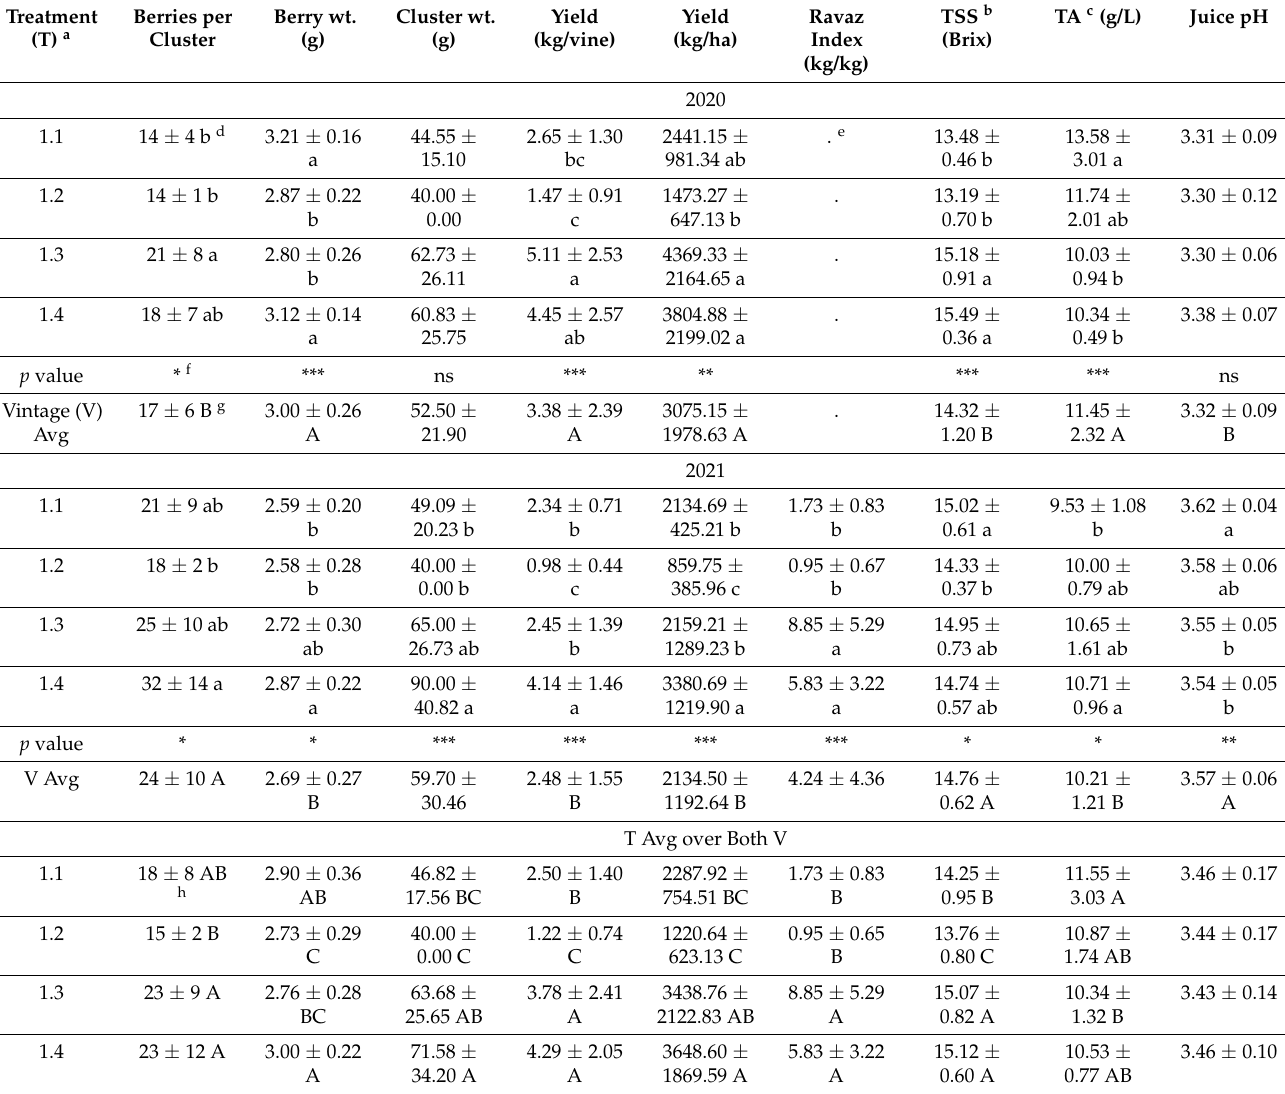
Table 2. ‘MidSouth’ mean ± standard deviation yield components and grape composition for each treatment, vintage, and treatment and vintage interaction in Study 1 in McNeill, MS (2020 and 2021). Berry wt.